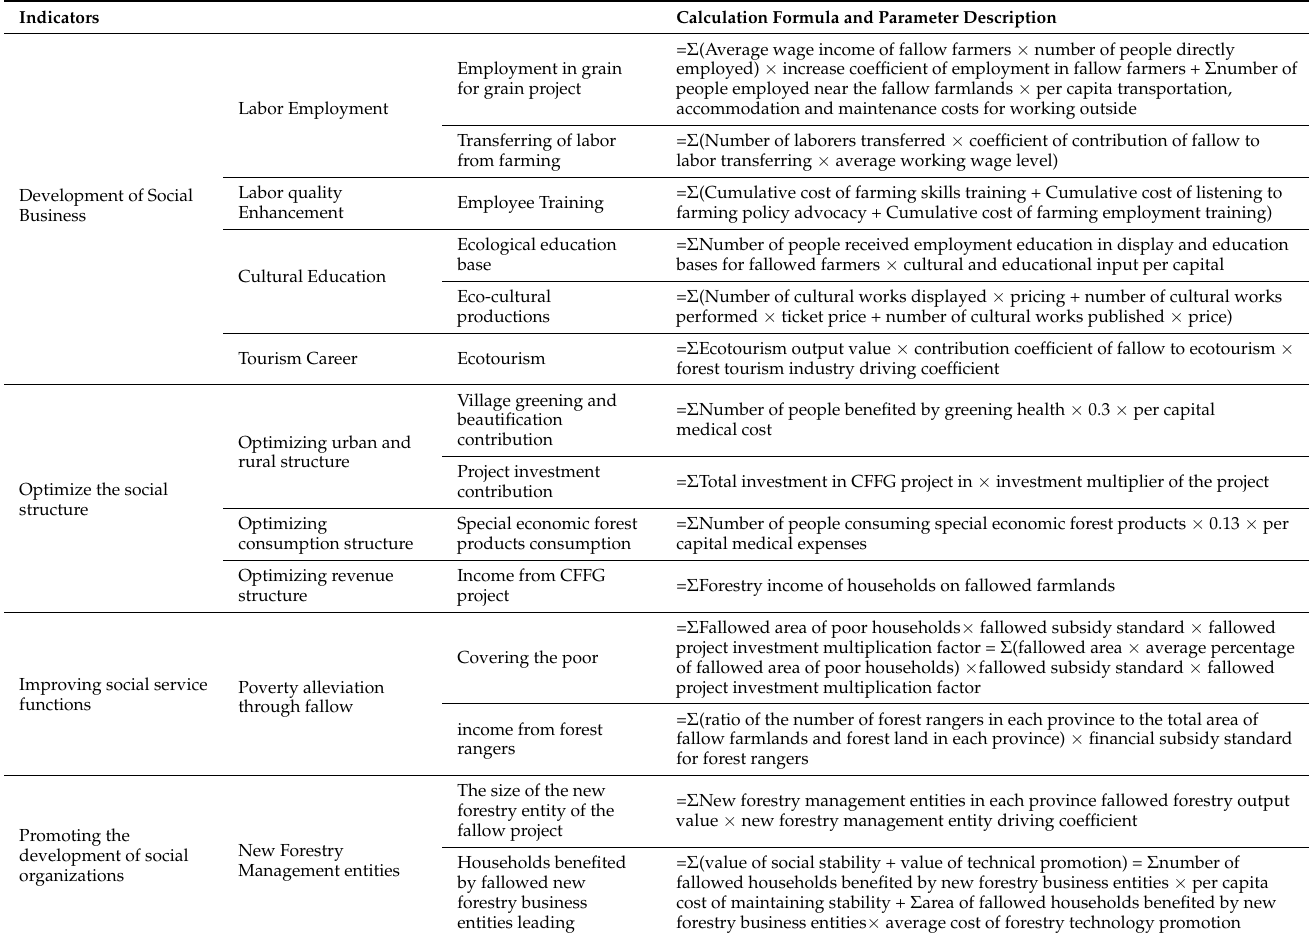
Table 3. Evaluation method of social benefit value of the CFFG